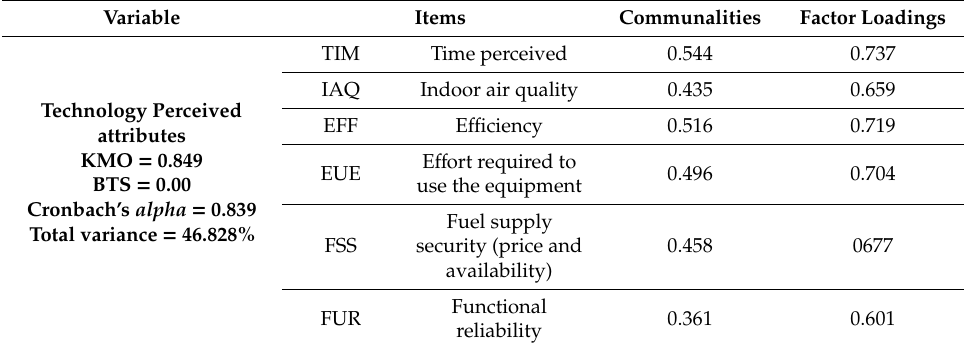
Table A2. Factor loading and communalities for